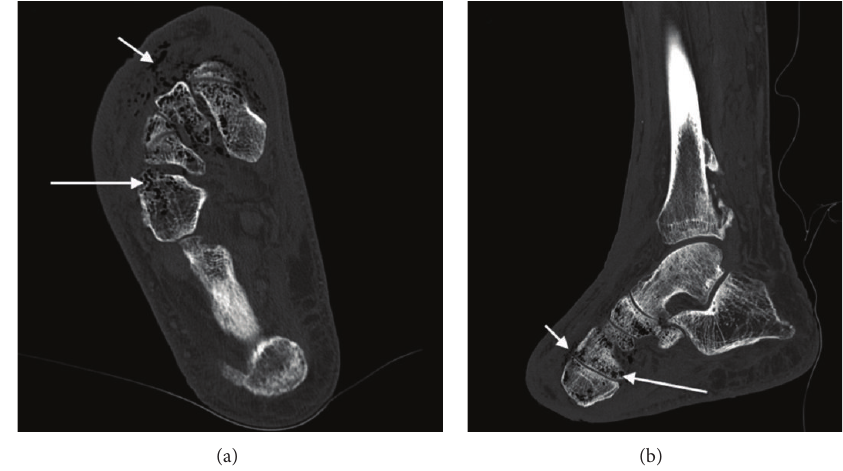
Figure 2: Computed tomography demonstrates gas within the midtarsal bones (long arrow, (a) and (b)) and head of talus and gas in the soft tissues surrounding the midfoot (short arrow, (a) and